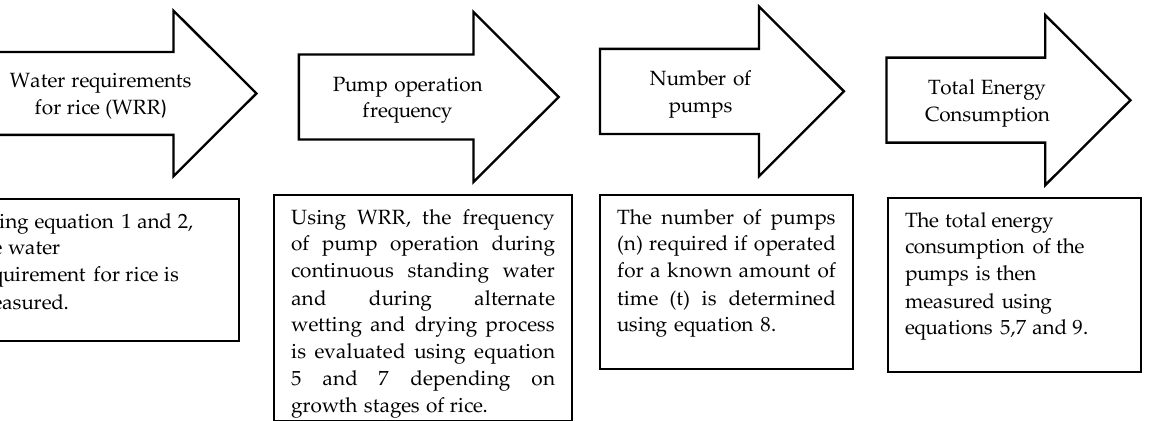
Figure 14. Required dimensioning and calculation steps for an IoT-based AWD system.